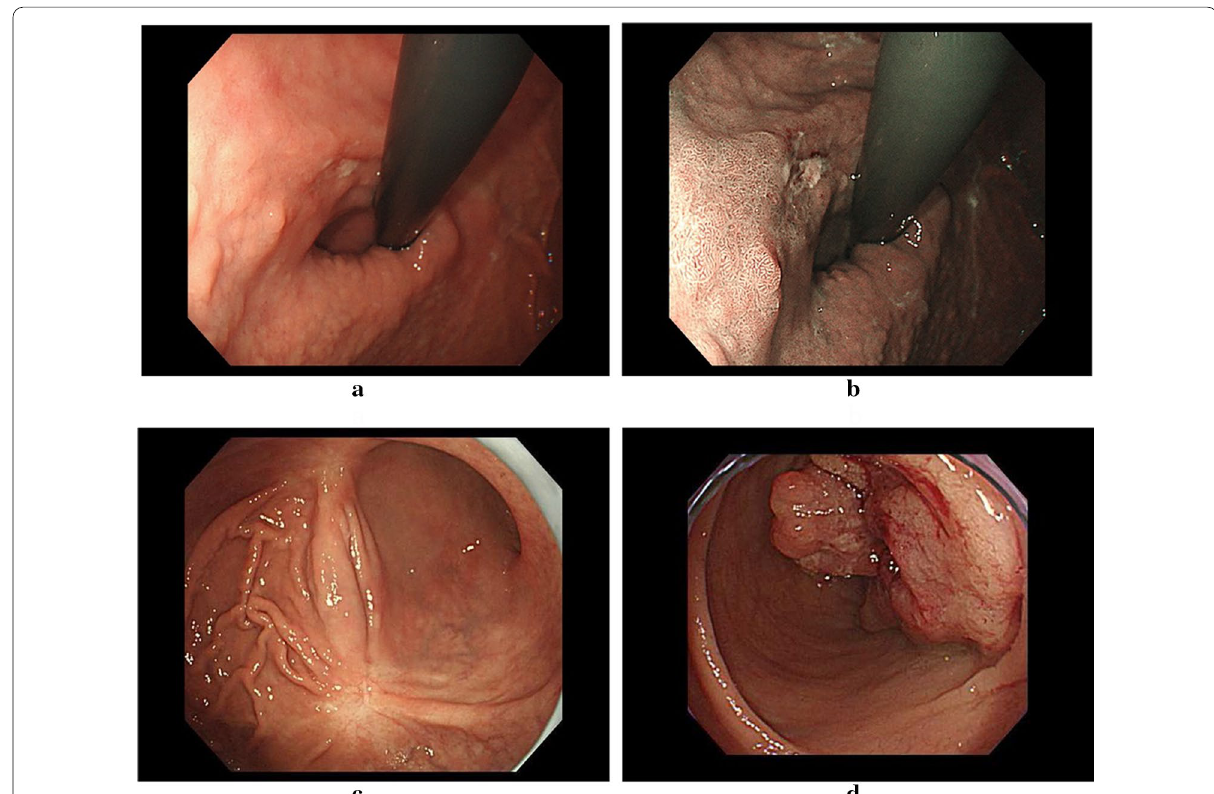
Fig. 1 a Lesion in the lesser curvature of the cardia by gastrointestinal endoscopy. b NBI image of lesion in the lesser curvature of the cardia by gastrointestinal endoscopy. c Suspected gastric cancer lesion at an ulcer scar on the posterior wall of the body of the stomach. d Type 2 lesion in the sigmoid colon by lower gastrointestinal